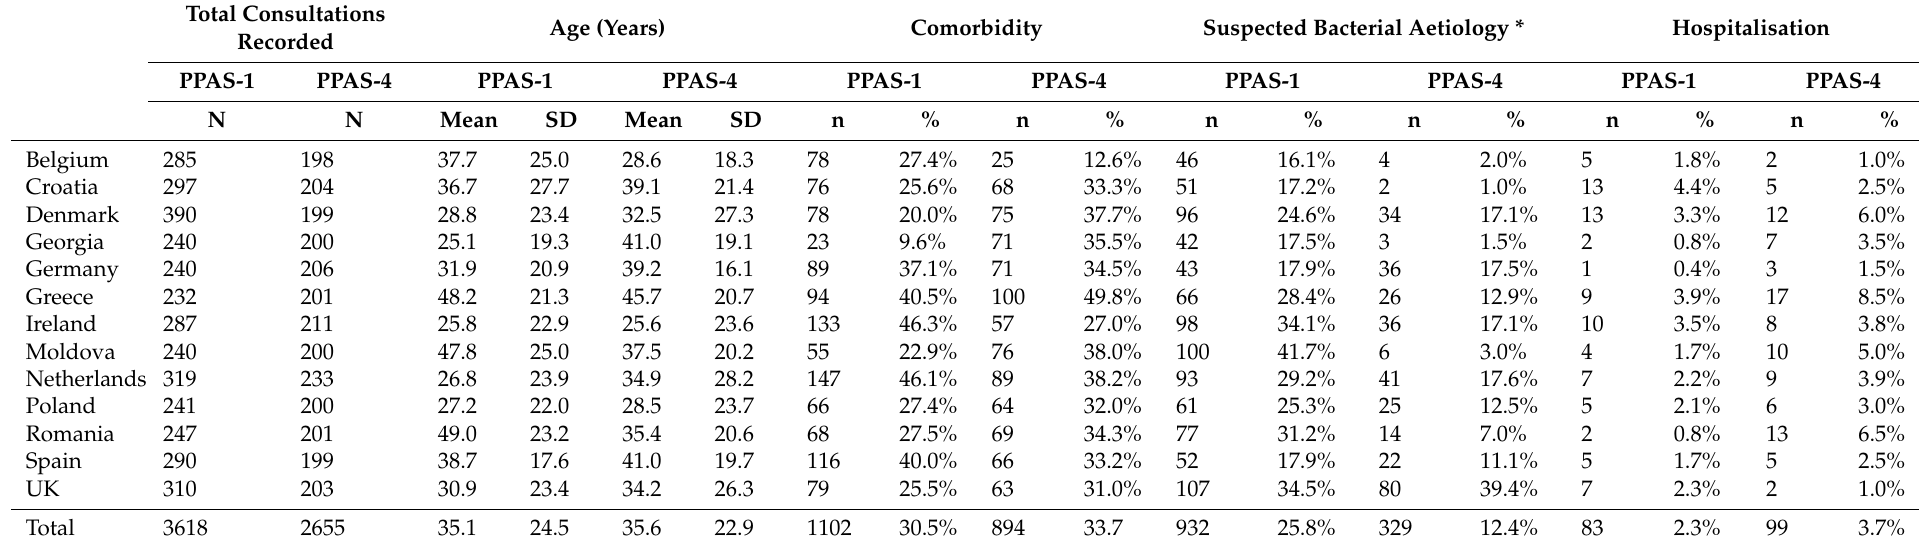
Table 1. Characteristics of recorded consultations in PPAS-1 and PPAS-4 by